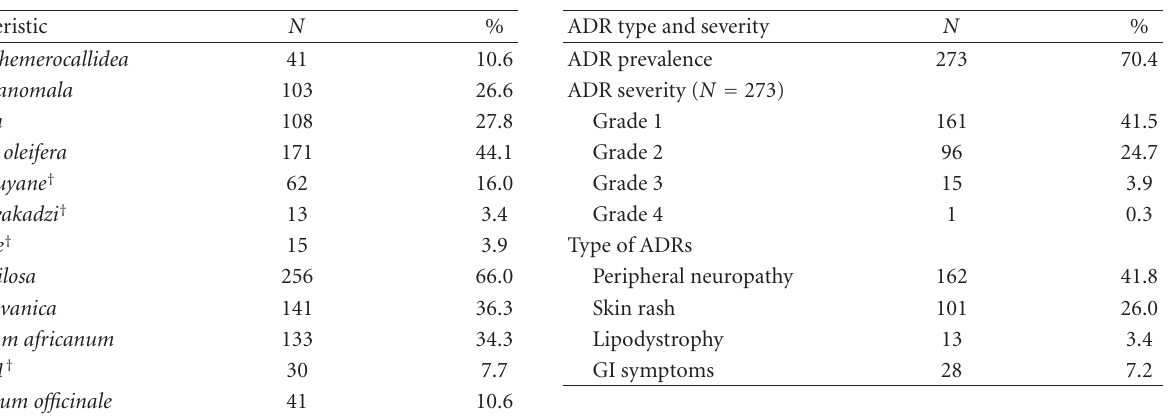
Table 2: Frequencies of herbal use in study population. Table 3: Prevalence of adverse drug reactions in the study